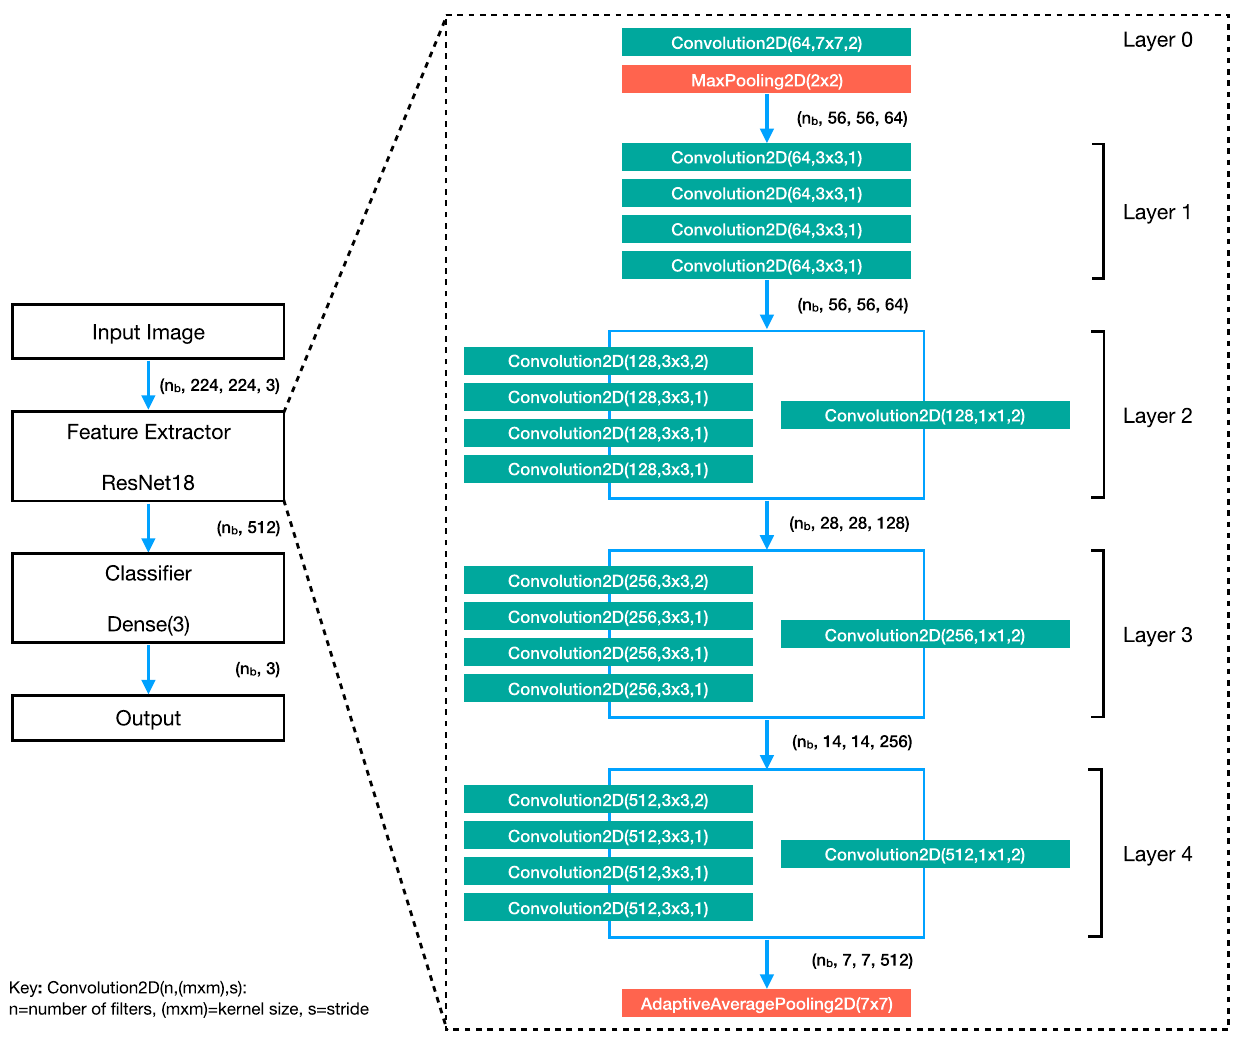
Fig. 2 An overview of the architecture, where 224 × 224 pixel images of depth three are input to the ResNet18 feature extractor that outputs a 512 element tensor. The classifier takes the 512 element tensor and outputs three classification scores, one for each class. The number of imagesperbatch, n b ,isshowninthetensordimensions.Forclarity,only the convolutional and pooling layers are shown for the feature extractor.